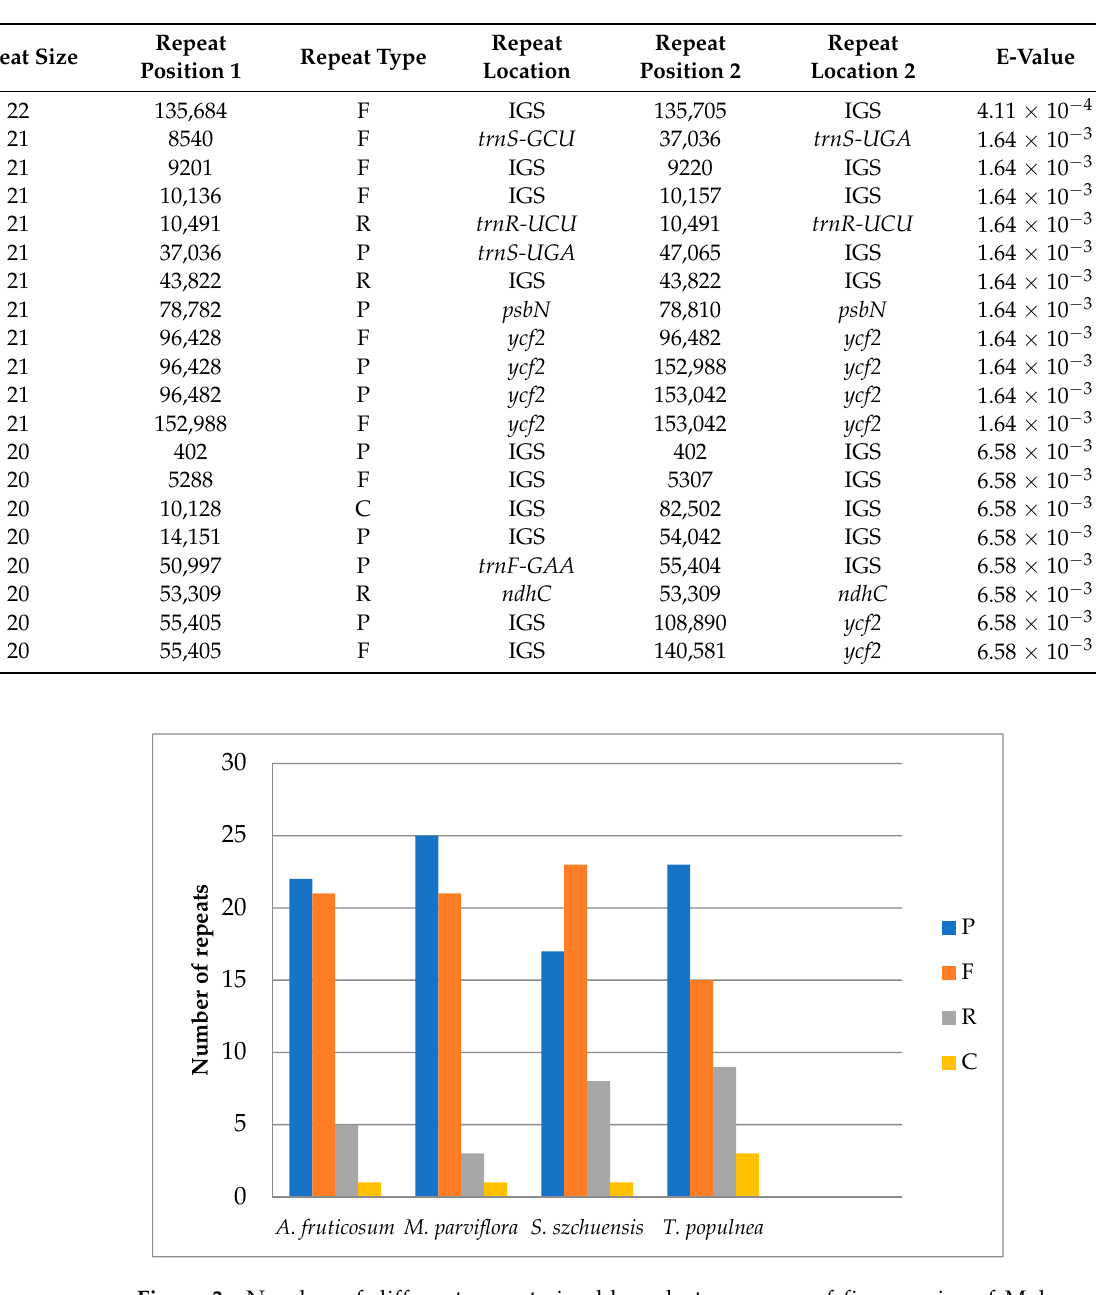
Figure 3. Number of different repeats in chloroplast genomes of five species of Malvaceae. P = palindromic, F = forward, R = reverse and C = complement.